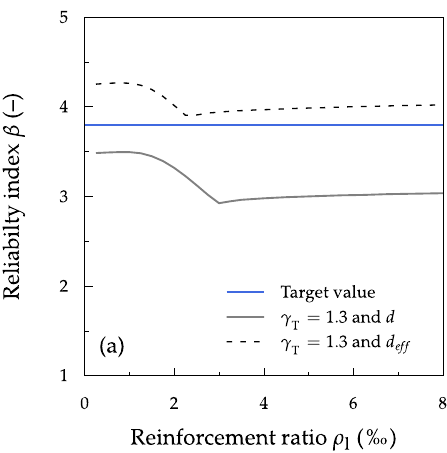
Figure 14. Reliability indices calculated according to FORM for the effective depth d and the reduced effective depth d red.